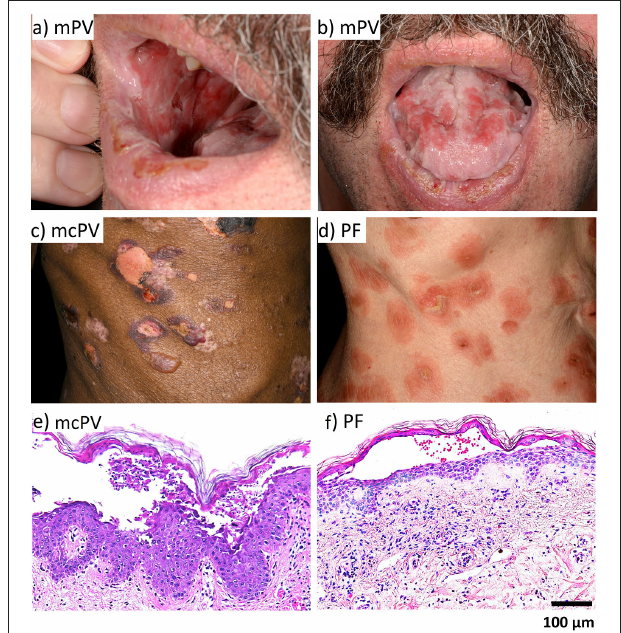
FIGURE 1 | The clinical phenotype and histology of PV and PF. (a) mPV. (b) mPV. (c) mcPV. (d) PF. (e) mcPV. (f) PF.